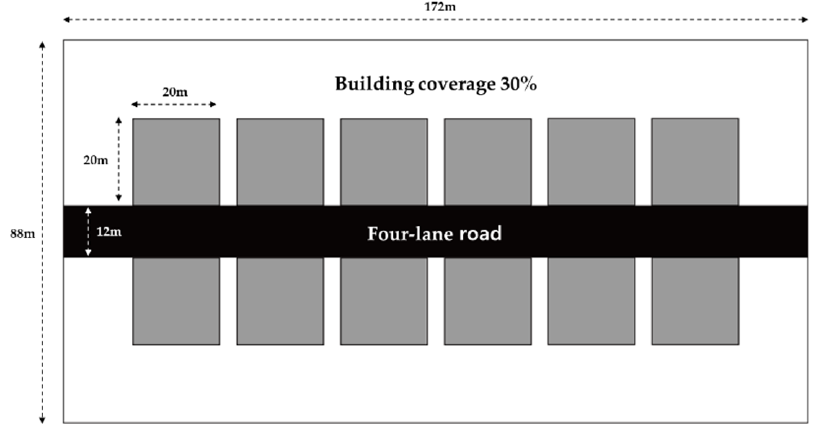
Figure 3. Simulation case model overview.